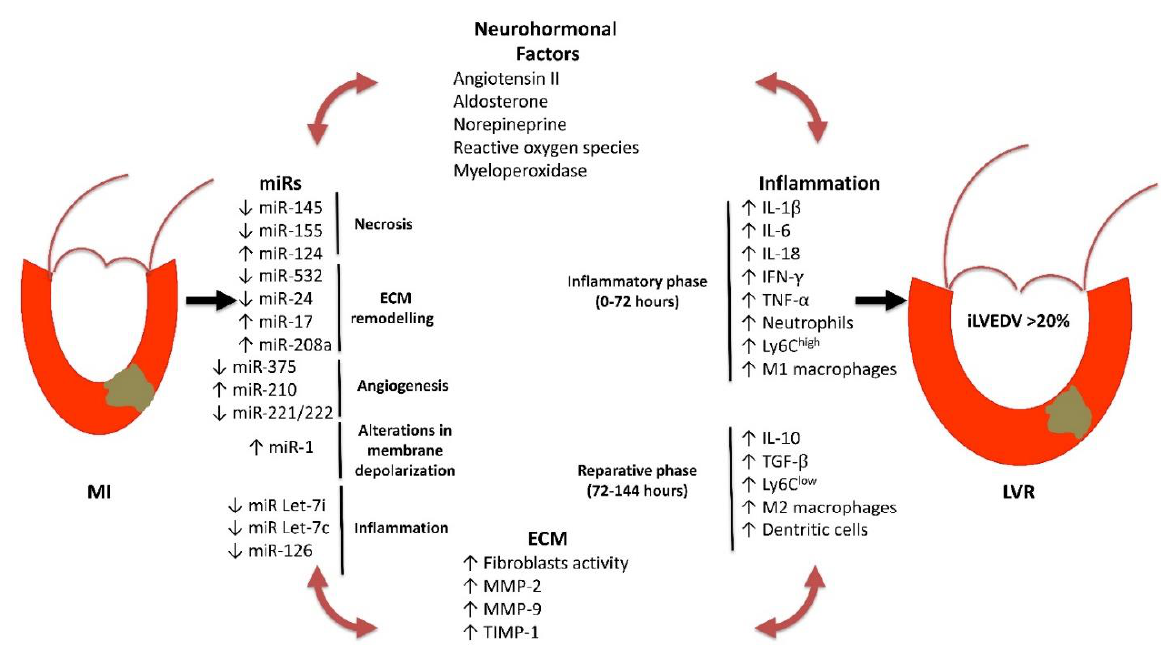
Figure 1. Schematic representation of the different mechanisms involved in the development of post-STEMI LVR. ECM: extracellular matrix; iLVEDV: indexed left ventricular end-diastolic volume; LVR: left ventricular remodeling; STEMI: ST elevation myocardial infarction; miRs: micro-RNAs; IL: interleukin; IFN- γ : interferon- γ ; TNF- α : tumor necrosis factor- α ; Ly6c: lymphocyte 6 cytotoxic; TGF- β: tumor growth factor - β; MMPs: metalloproteinases; TIMPs: tissue inhibito r of met- alloproteinases. ↑ indicates an increase; ↓ indicates a decrease.